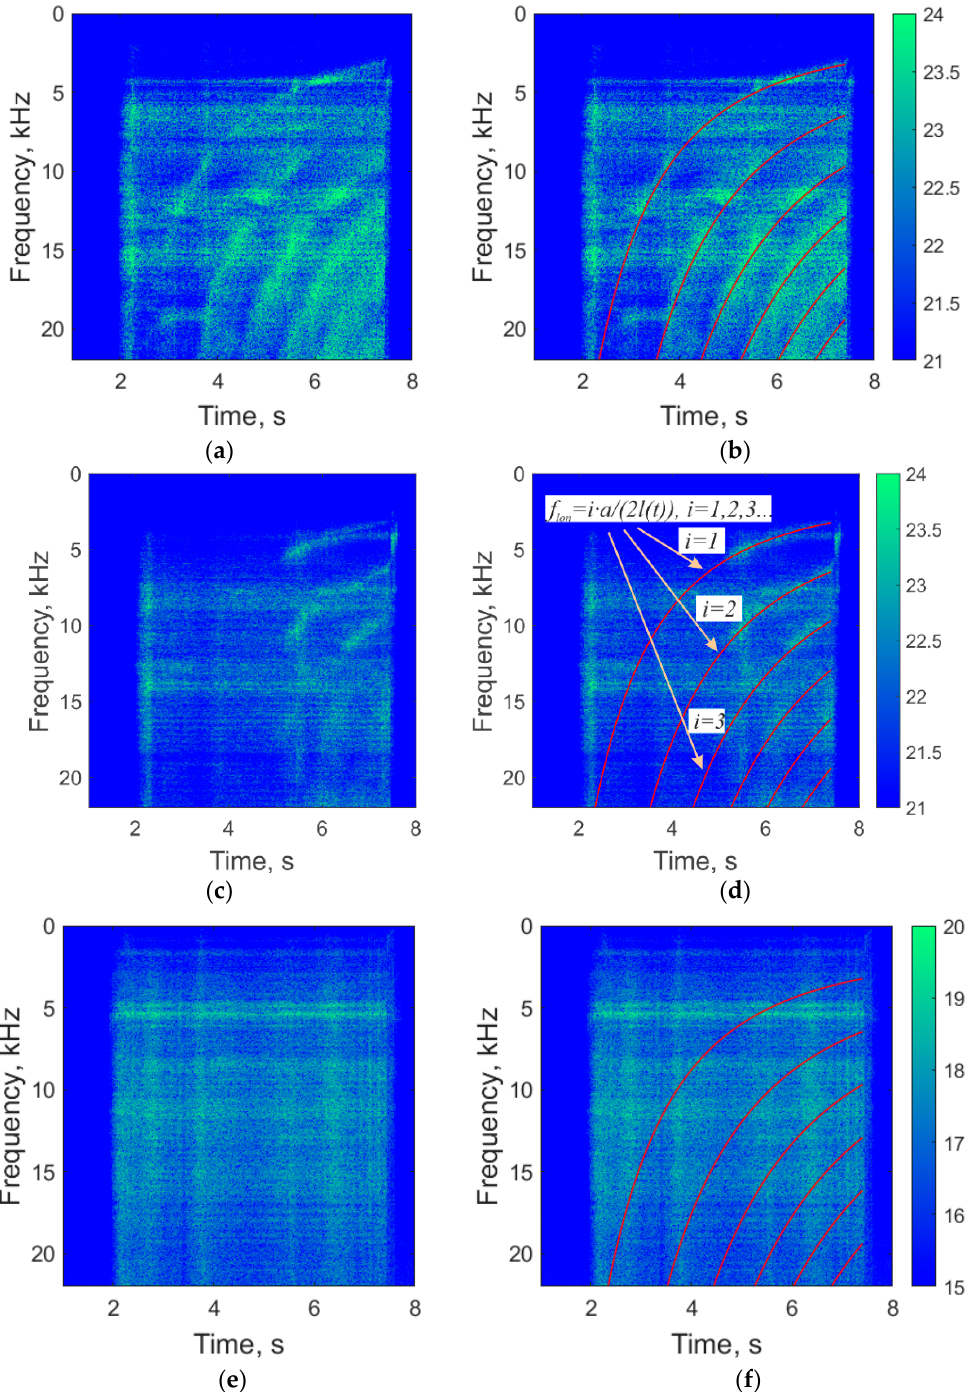
Figure 12. Spectrograms of the housing diameter deformation signals recorded by sensors: pure graphs MZI1 ( a ), MZI2 ( c ), MZI3 ( e ), and the same with marked ideal longitudinal mode and its harmonics for MZI1 ( b ), MZI2 ( d ), and MZI3 ( f ).